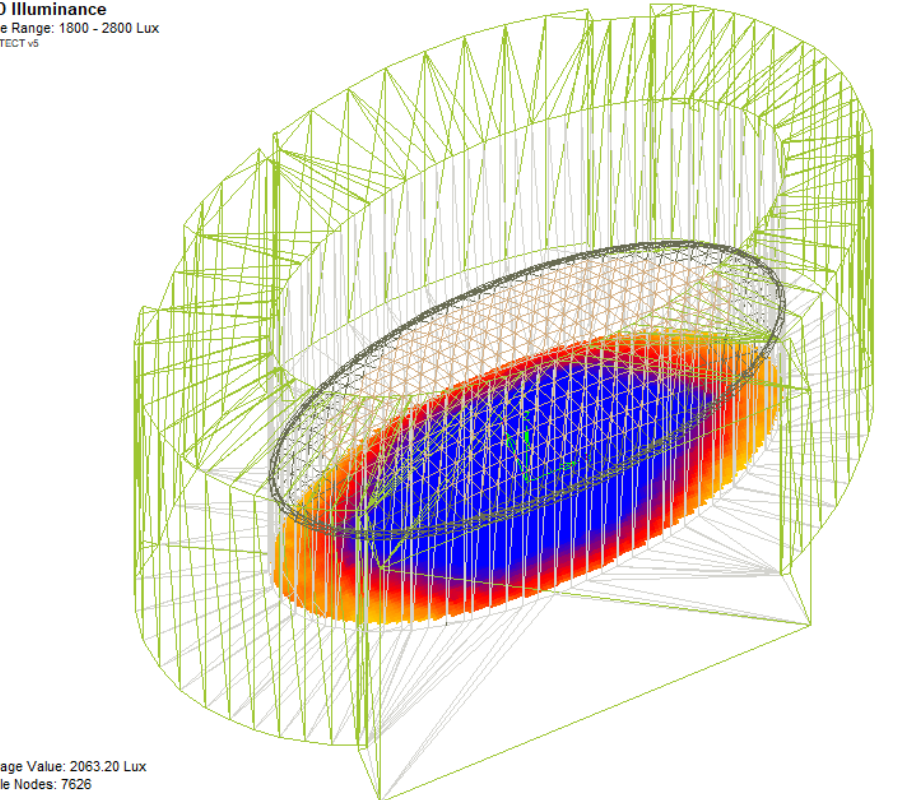
Figure 3. Natural lighting model